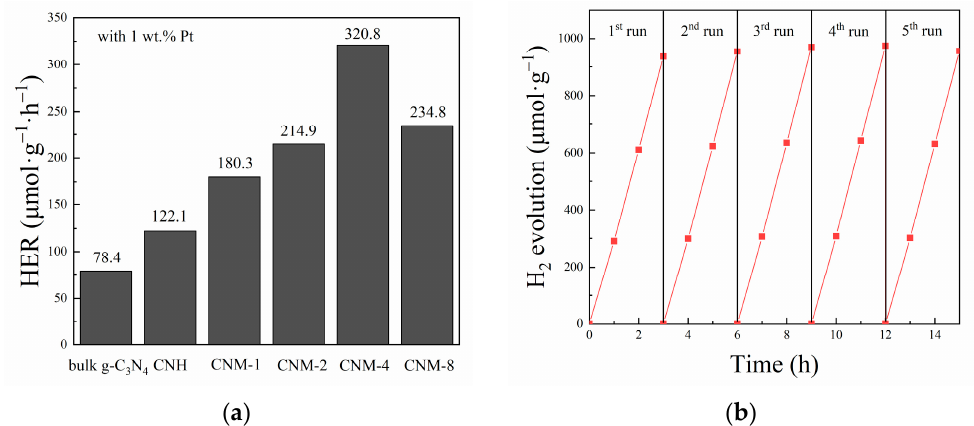
Figure 6. ( a ) Photocatalytic H 2 evolution rate of bulk g-C 3 N 4 , CNH, and all exfoliated g-C 3 N 4 /MoO 2 composites; ( b ) cycling performance for H 2 evolution over the optimal CNM-4 composite.